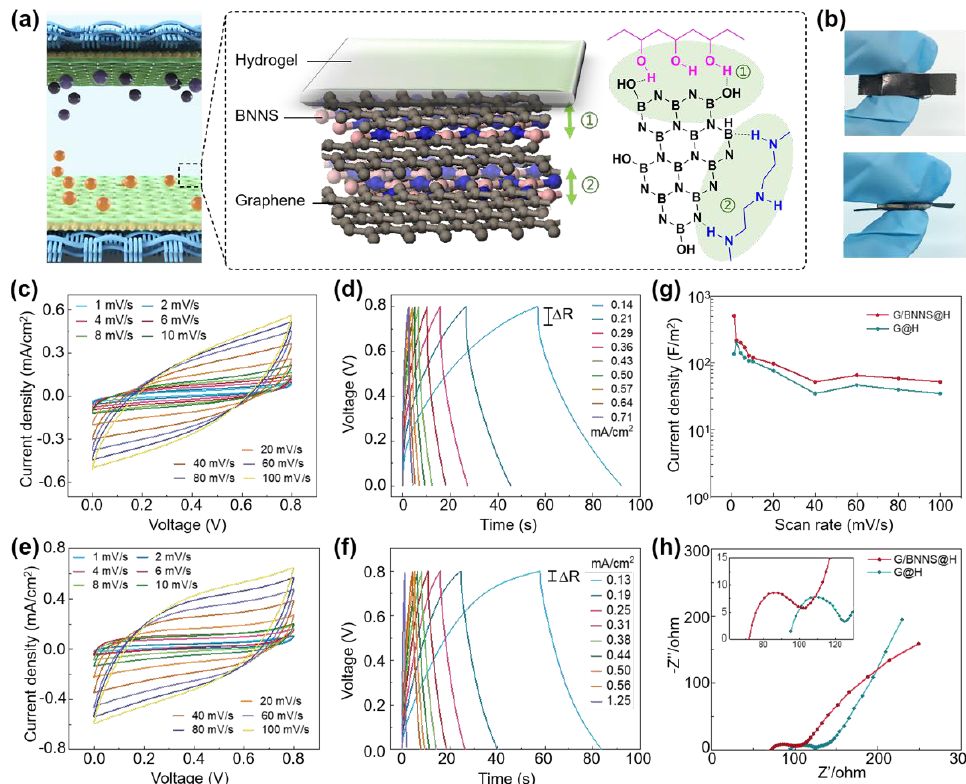
Figure 4. The electrochemical behavior of the WSCs. ( a ) The interaction among the electrolyte, BNNS and graphene. ( b ) the optical image of the WSC. CV ( c ) and galvanic charge/discharge (GCD) ( d ) curves of the WSC based on G@H. CV ( e ) and GCD ( f ) curves of the WSC based on G/BNNS@H. ( g ) Areal capacitances of WSCs at different scan rates. ( h ) Nyquist plot for WSCs based on G/BNNS@H and G@H.